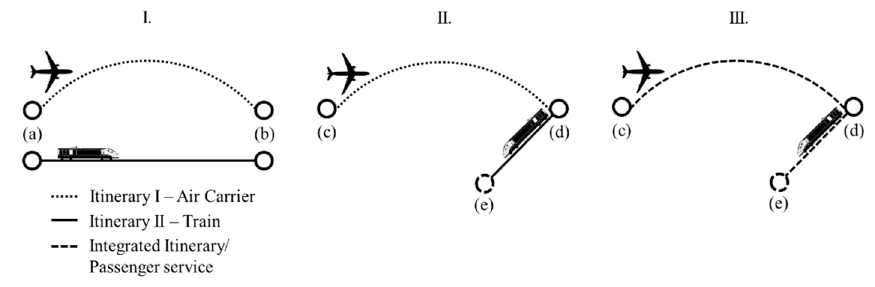
Figure 2. Travel pattern for I. Modal competition, II. Modal cooperation, and III. Modal